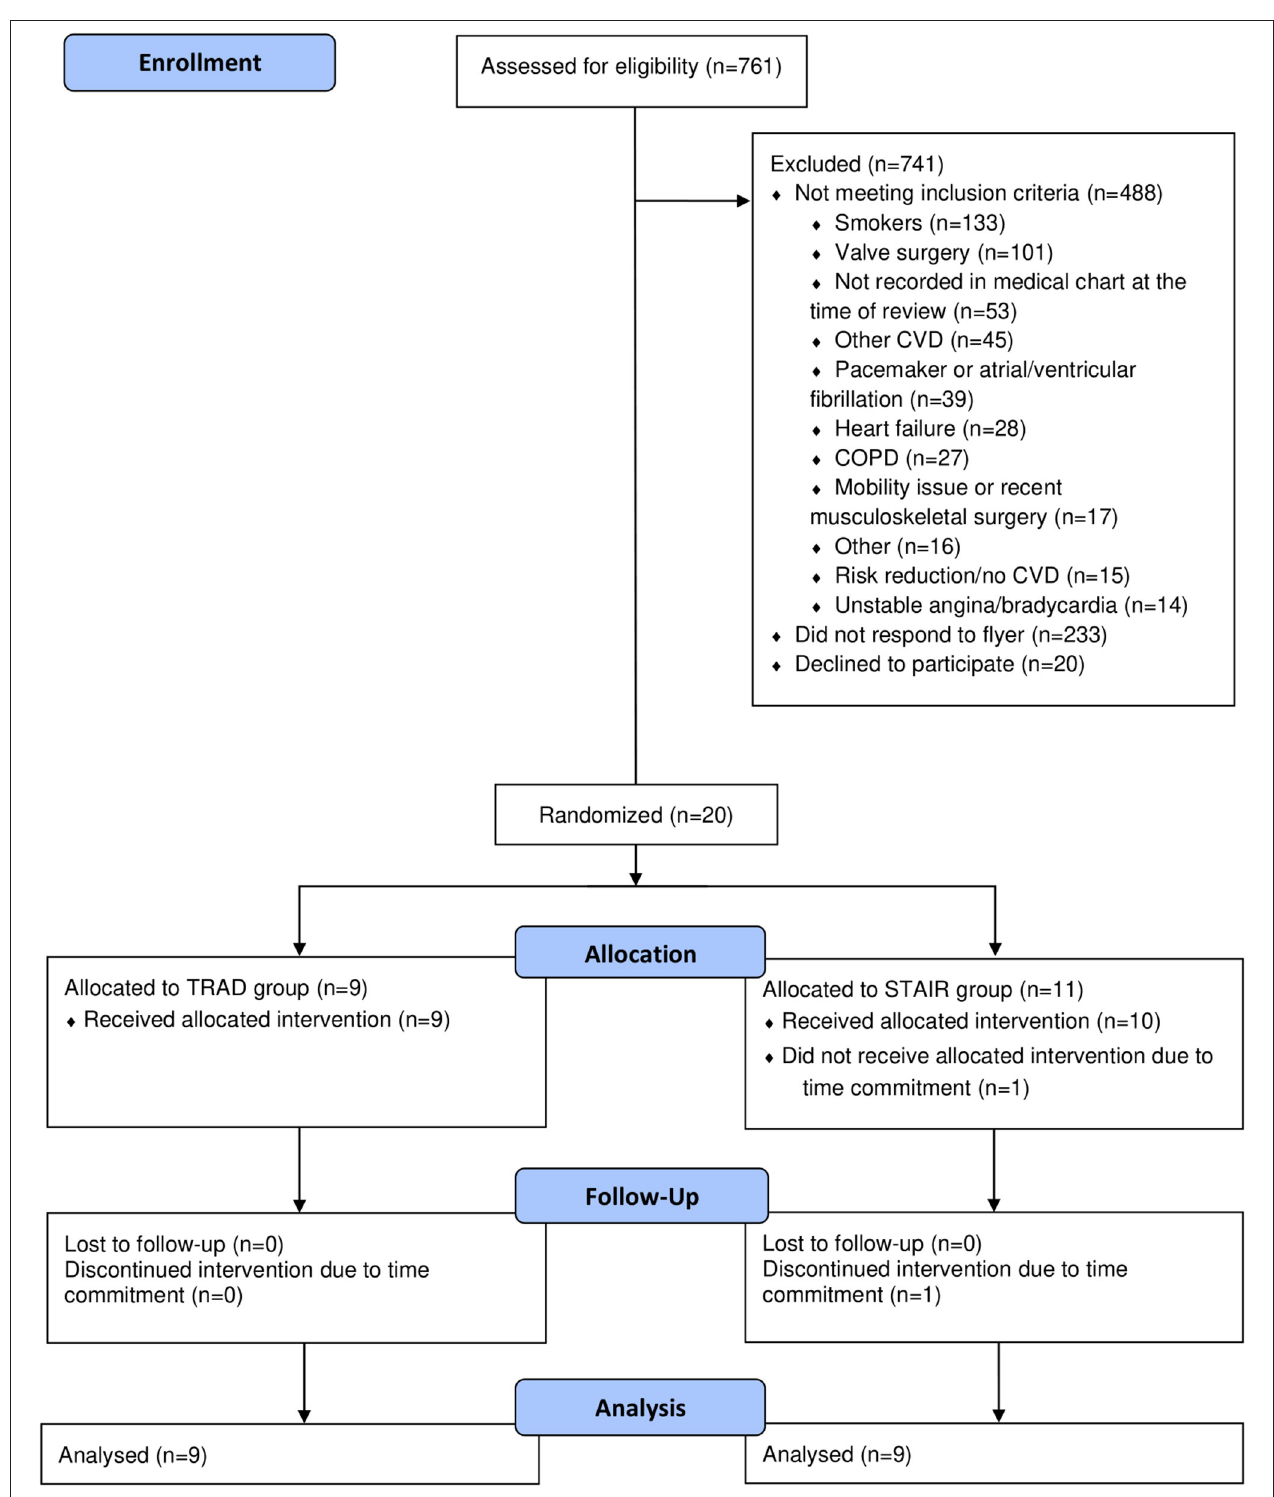
FIGURE 2 | CONSORT flow diagram. CONSORT, Consolidated Standards of Reporting Trials; TRAD, Traditional moderate-intensity continuous exercise training; STAIR, stair climbing-based high-intensity interval training.